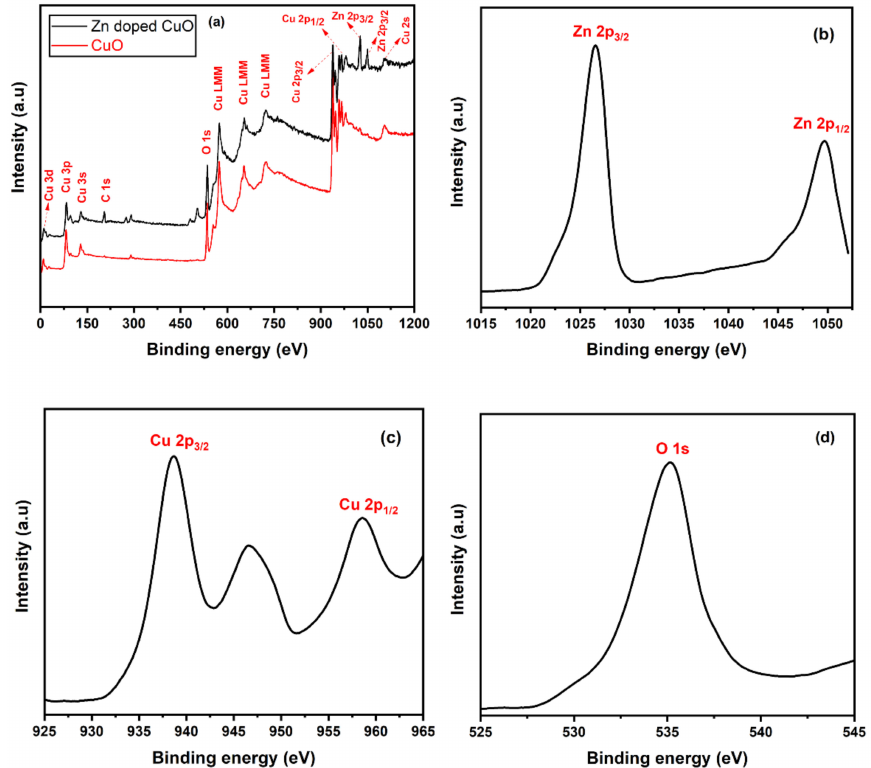
Figure 5. ( a ) X-ray photoelectron spectroscopy (XPS) survey of the as-synthesized Zn-doped CuO nanostructures. ( b ) High